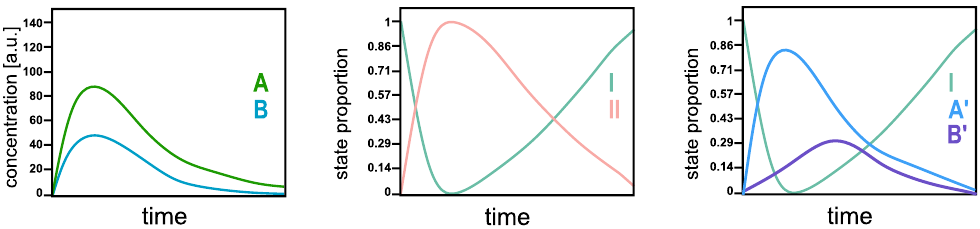
Figure 2. Qualitative comparison of kinetic profiles with MCR and SepFree NMF. MCR ( left ), SepFree NMF of rank 2 ( middle ), SepFree NMF of rank 3 ( right